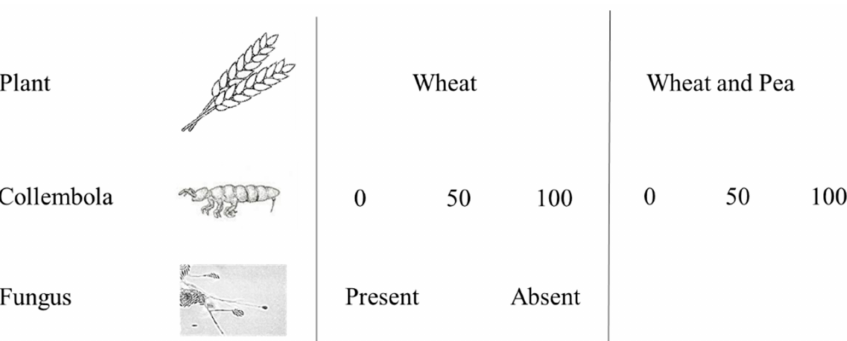
Figure 1. Description of the treatments used in the experiment.